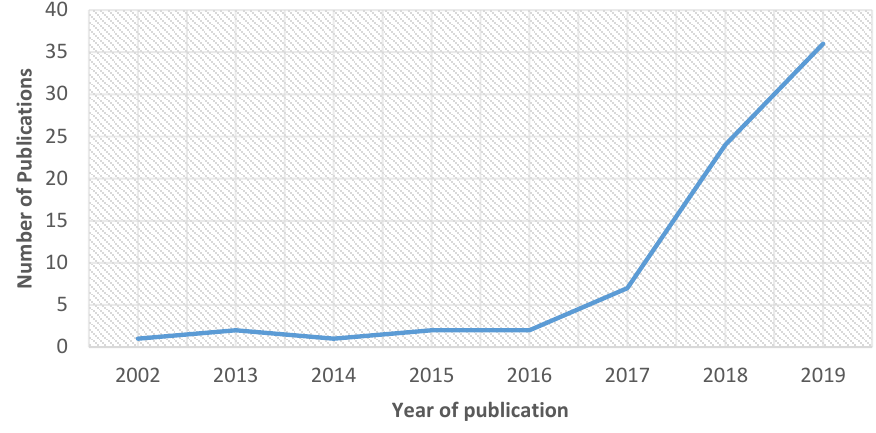
Figure 5. Year of the studied publications.